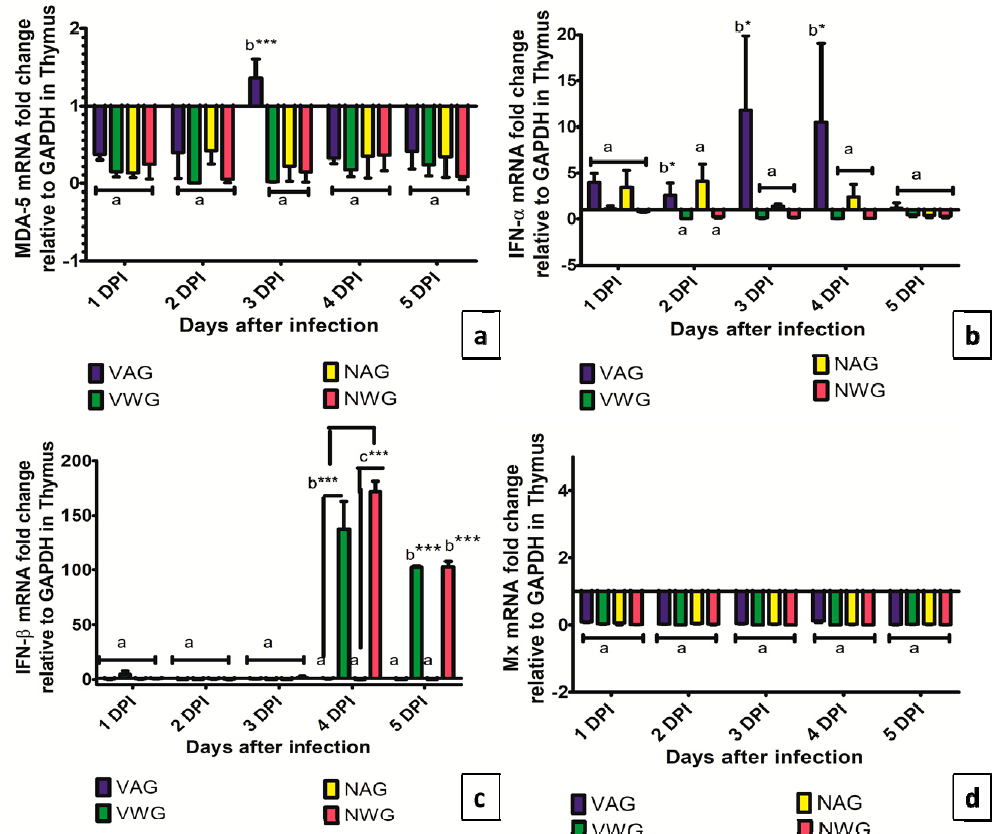
Figure 8. Expression of ( a ) MDA-5 ( b ) IFN- α ( c ) IFN- β ( d ) Mx. genes in thymus of vaccinated and non-vaccinated Aseel and White Leghorn chicken infected with very virulent IBDV. The groups were as follows: VAG-Vaccinated Aseel Group; VWG-Vaccinated WhiteLeghorn group; NAG-Non-vaccinated Aseel Group; NWG- Non-vaccinated WhiteLeghorn Group. Error bars represent standard error of the mean. Relative changes in the expression of genes were quantified by real-time PCR by comparison with expression levels of the housekeeping gene GAPDH and expressed as the fold-change. The value of 1.00 was kept as the control and the fold change values which were above the control values were considered as significant. *significant difference comparing VAG with VWG and NAG with NWG chickens of the same line at the same point where P < 0.05*, P < 0.001***. ( a - c ): Experimental groups sharing common lowercase superscript letters are statistically non-significant for each observation day.